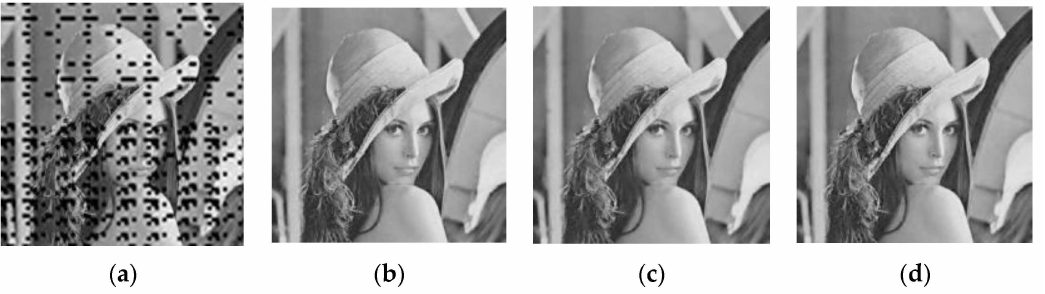
Figure 3. 10% wavelet coefficients of Lenna are randomly lost. ( a ) received image. ( b – d ) images reconstructed by TVL2, TVL0, and TVL1, respectively.